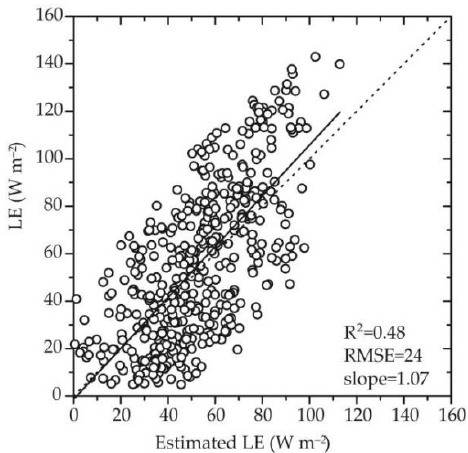
Figure 4. Comparison between ET estimated by Equation (2) and the measured value of the station in Table 1, where the bold black line represents the fitting line of scattered points and the dotted black line represents the 1:1 line.